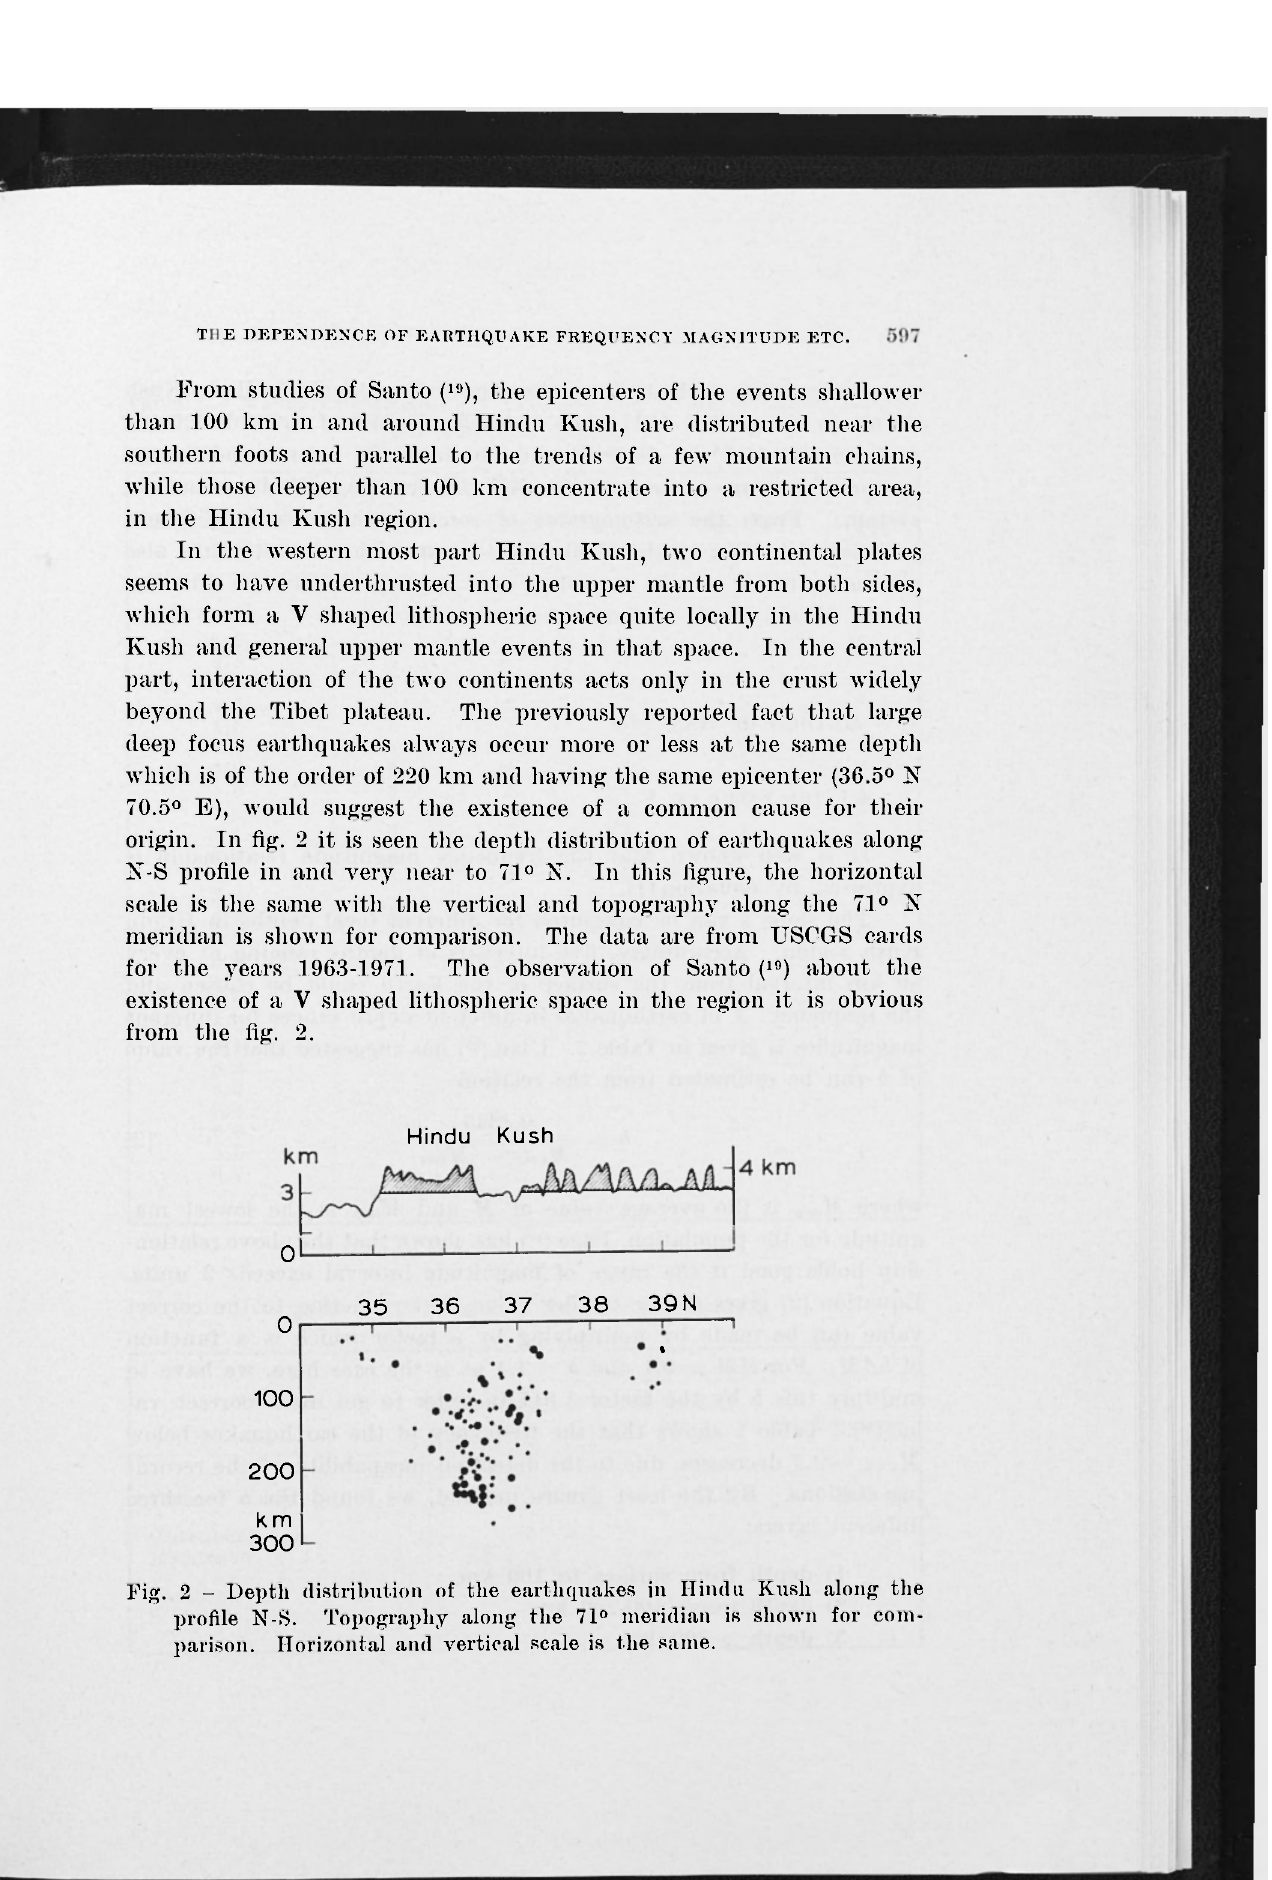
Fig. 2 - Depth distribution of the earthquakes in Hindu Kusli along the profile N-S. Topography along the 71° meridian is shown for com- parison. Horizontal and vertical scale is the